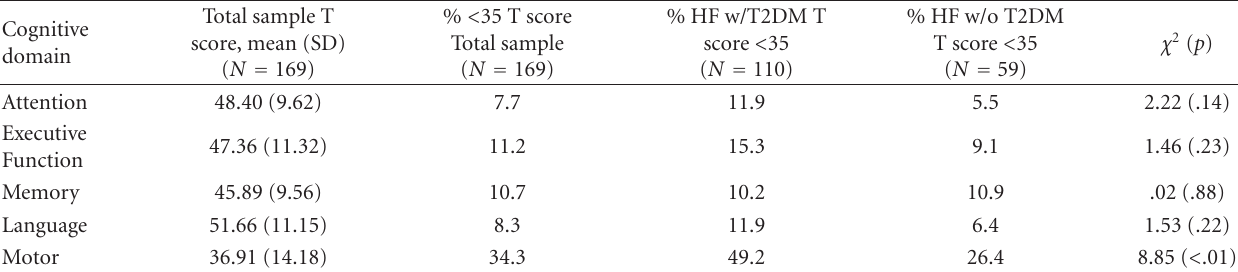
Table 2: Cognitive impairment in older heart failure adults with and without type 2 diabetes